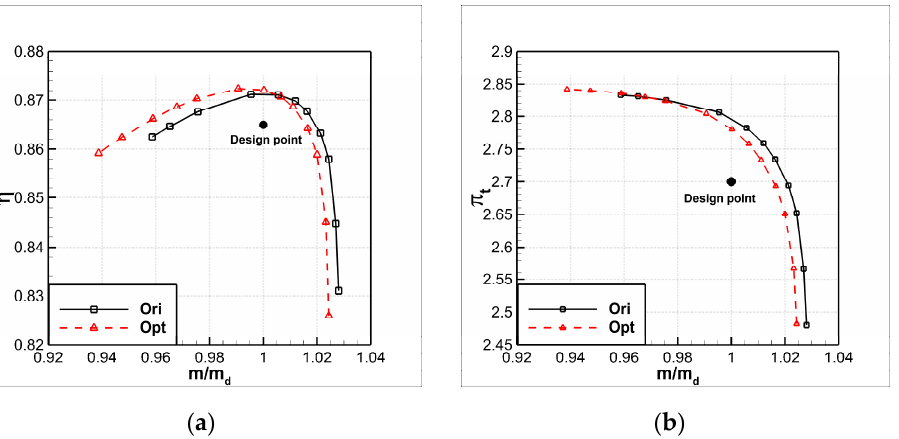
Figure 9. Original and optimized compressor performance maps. ( a ) Adiabatic efficiency at the different normalized mass flow; ( b ) total pressure ratio at the different normalized mass flow.